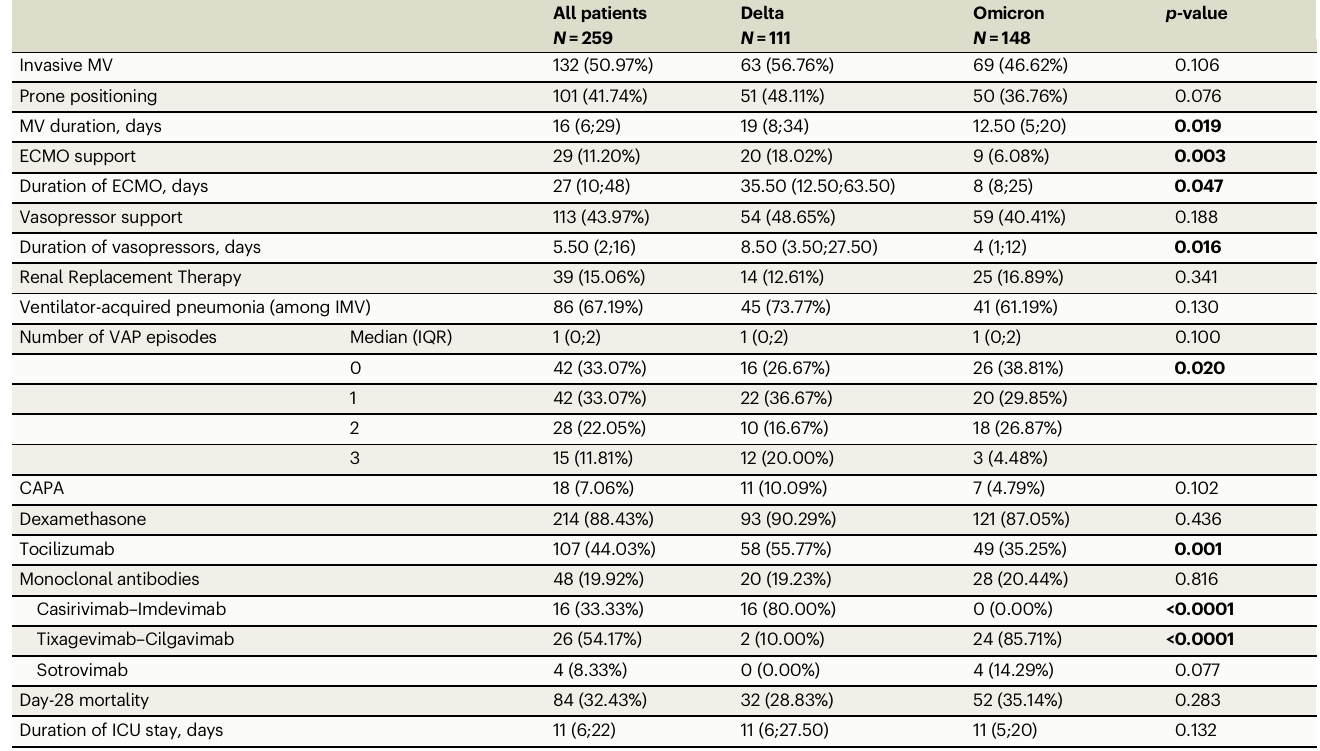
Table 2 | Intensive care management and outcomes of patients with severe SARS-CoV-2 infection ( n = 259) during their intensive care unit stay according to the SARS-CoV-2 infecting variant (Delta or Omicron)